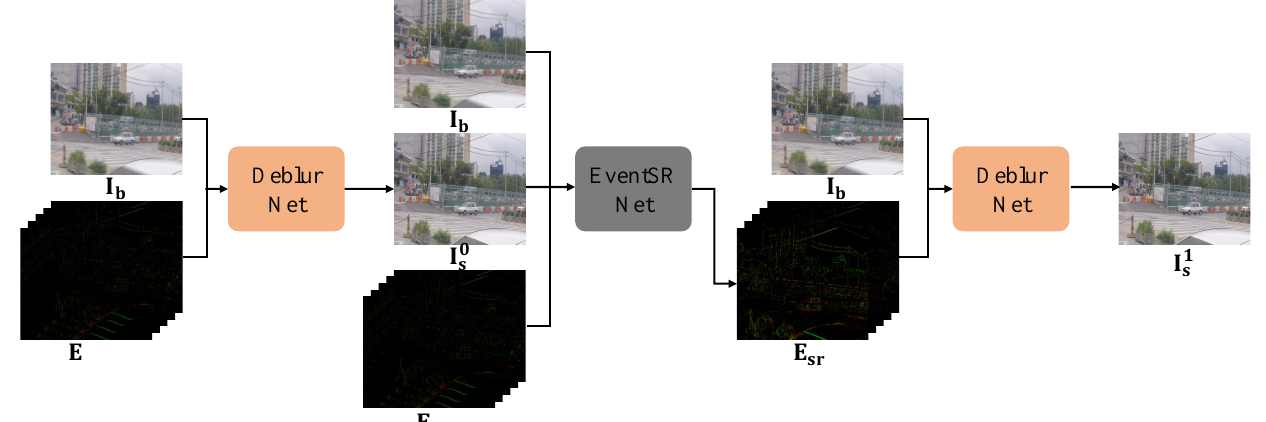
Figure 3. Framework of the proposed model. It contains two components: DeblurNet and EventSR- Net. The whole reference process consists of three steps. The first step is to attain the preliminary sharp intensity images I 0 s from low-resolution events E and high-resolution blurry intensity image I b . The second step tends to promote the resolution of events E to E sr with the help of I b and I 0 s . Finally, the super-resolved events E sr and I b are sent into another DeblurNet for achieving a better sharp intensity